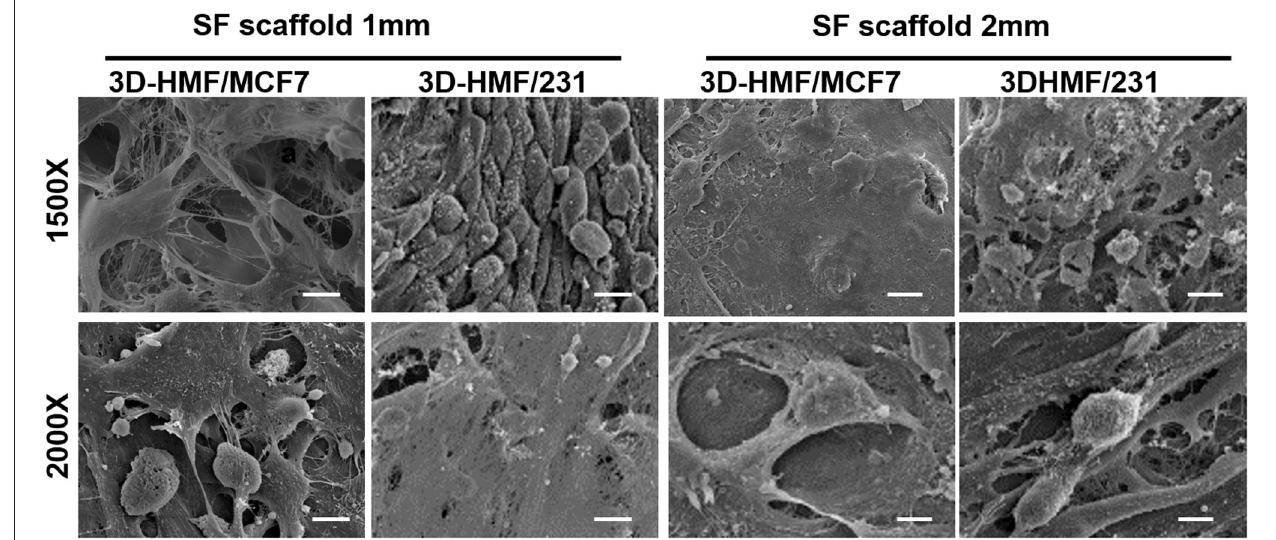
FIGURE 5 | Scanning electron micrographs of the developed 3D tumor models. 3D-HMF/MCF7 and 3D-HMF/231 in 1mm and 2mm SF scaffolds are fixed in 2.5% glutaraldehyde at day 14 of co-culture. The scale bar is 10 µ m for the 1,500 × magnification and 15 µ m for the 2,000 × magnification